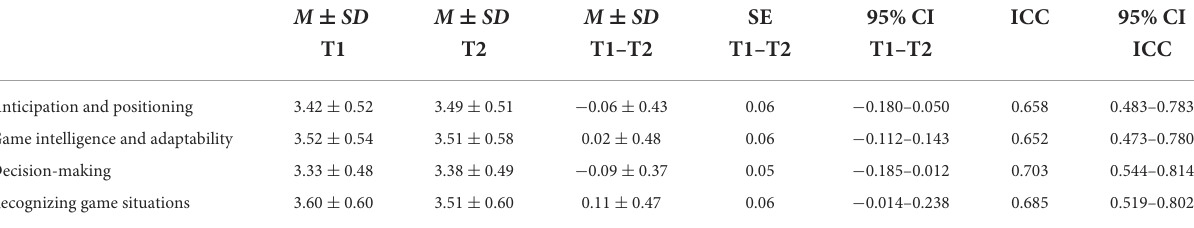
TABLE 4 Test-retest reliability for each subscale of the TSQT ( n = 57).